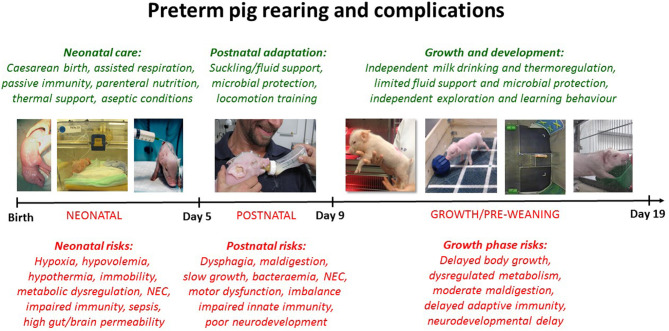
Illustration of clinical care procedures (green text) and possible morbidities (red text) for cesarean-delivered 90% gestation preterm pigs, reared as models for preterm infants. Preterm pigs show clinical and physiological characteristics reflecting very preterm infants (<32 weeks gestation) but comparisons to infants are both age- and organ-specific (37). Based on the reports of gender-specific morbidities in preterm infants, we investigate if sex-specific effects are present in preterm pigs at different stages after preterm birth.